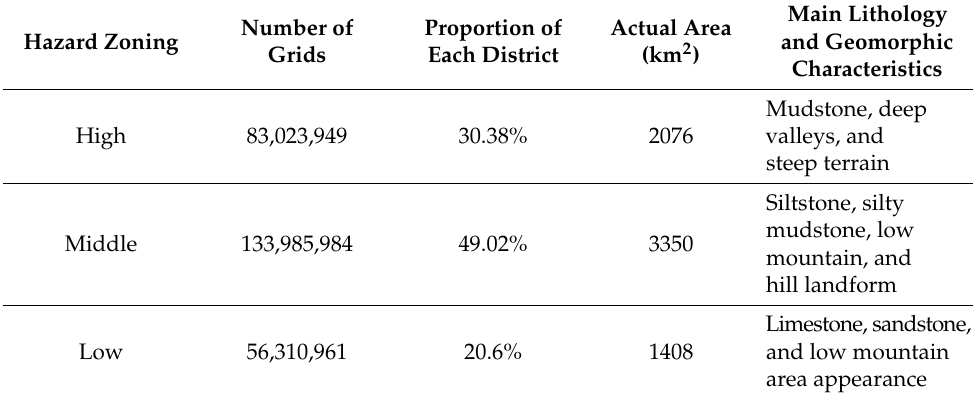
Table 2. Hazard zoning statistics table.